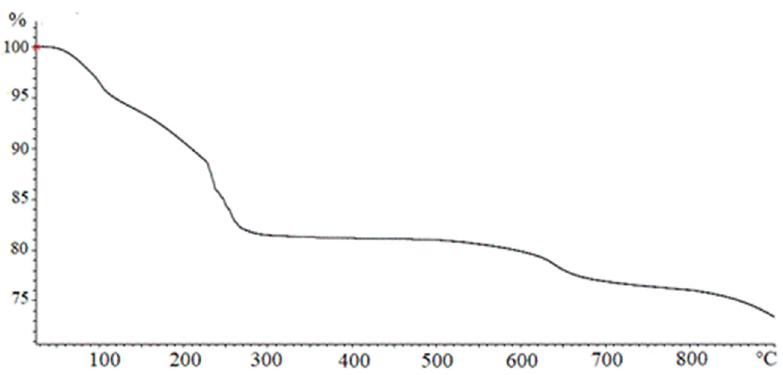
Figure 3. Thermogravimetric analysis (TGA) analysis on a Fe(OH) 3 sample.